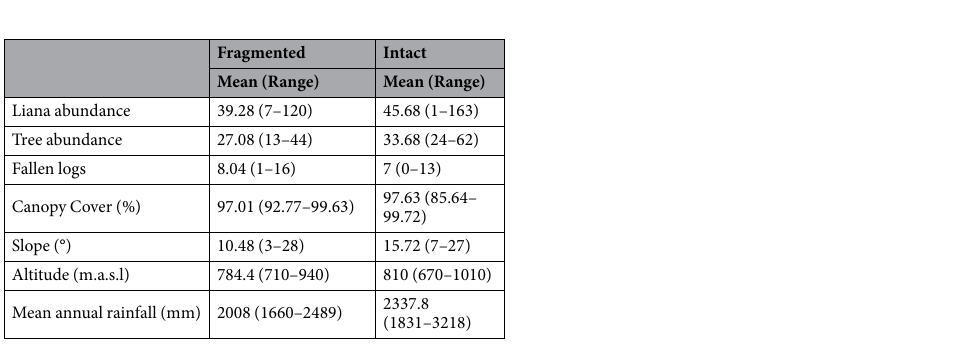
(Fig. 1). Despite considerable variation in environmental and ecological traits (Table 1, Supplementary Tables 1, 2 and 3), forest state (fragmented or intact) was the only significant predictor of total and adult rattan abundance within the landscape, with more rattans occurring in fragmented than intact forests (Fig. 1, Table 2). Additionally, adult and total rattan abundances displayed a positive relationship with distance from the forest edge whilst the relationship between juvenile rattan abundance and distance from the forest edge was negative, though these relationships were not significant.